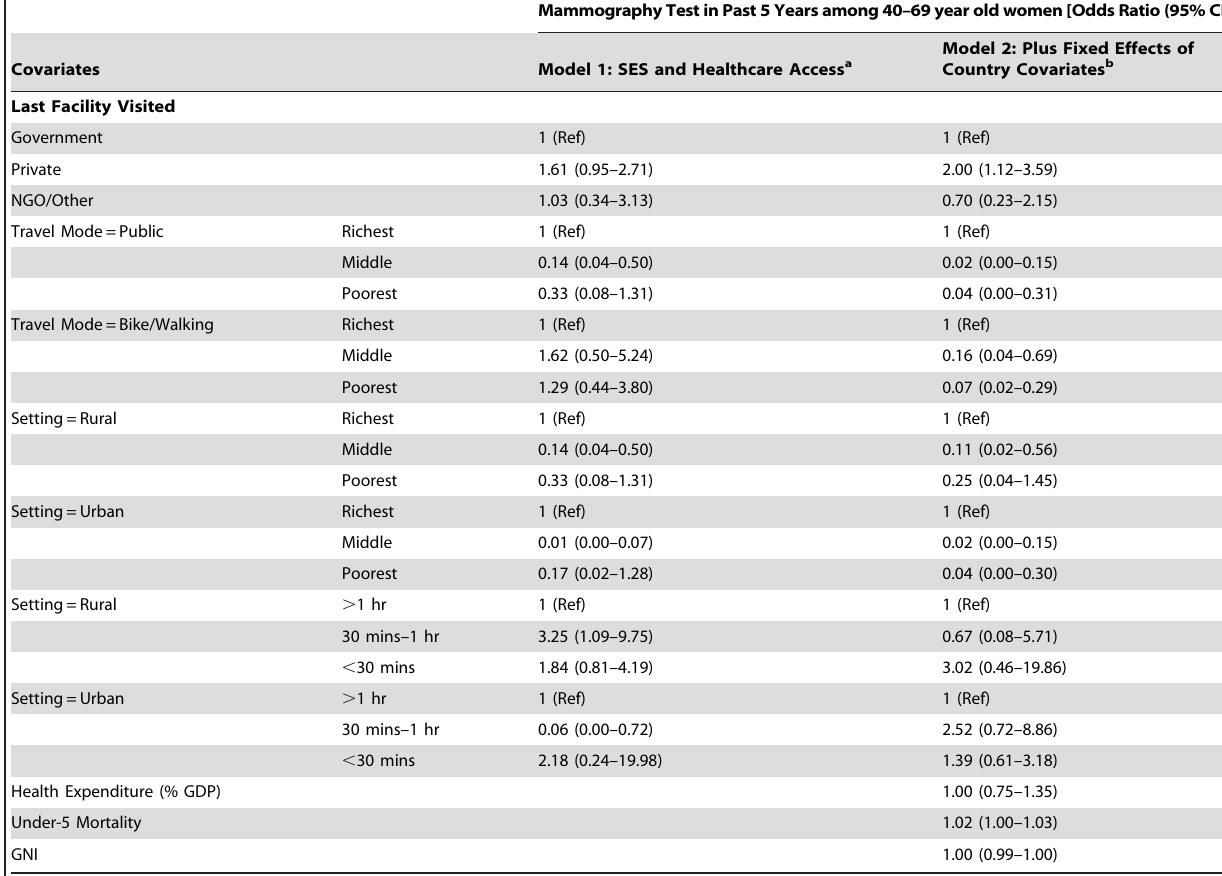
Table 3. Socio-Demographic Economic and Healthcare Access Determinants of Breast Cancer Screening.